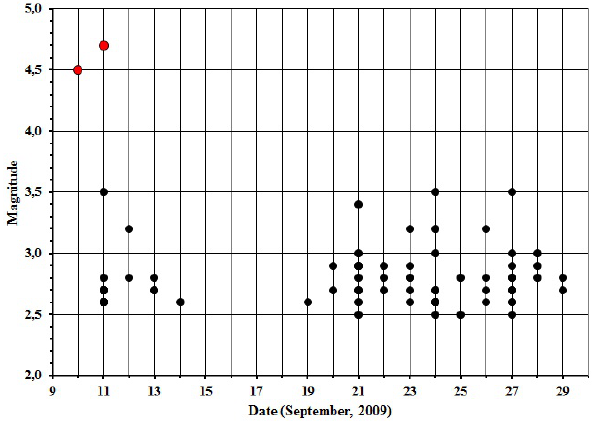
Fig. 2. History of the main shocks and aftershocks with magnitudes greater than or equal to 2.5 occurring between 9–30 September 2009 (data from Koeri, http://www.koeri.boun.edu.tr). crests to the Konya depression become flat-bottomed